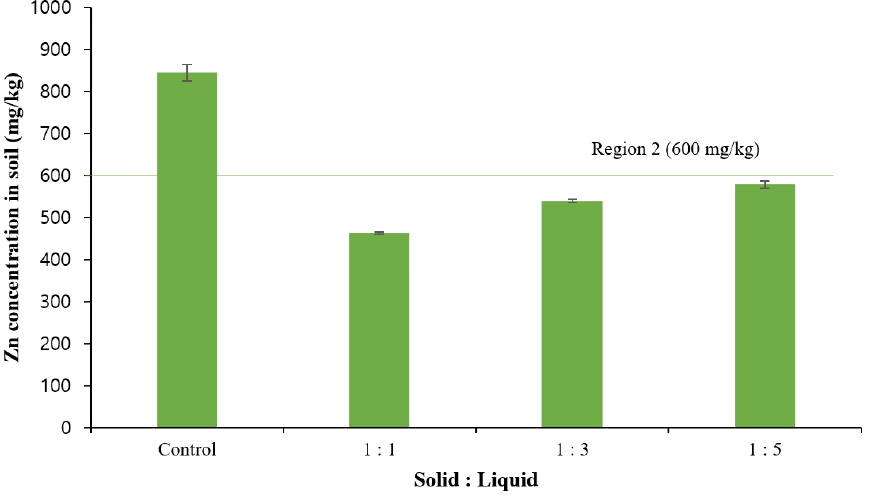
Figure 8. Zn concentrations remaining in the soil using a solid-liquid ratio of 1:1, 1:3 and 1:5 for the washing of soil.